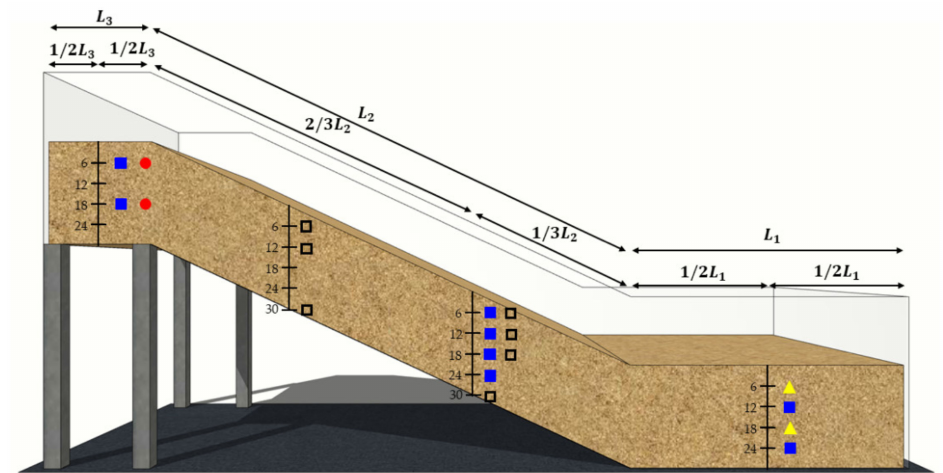
Figure 14. Positions of the embedded sensor network in the slope model: yellow triangles—TEROS 12, red dots—TEROS 21, blue squares—TEROS 10, and black squares—MEMS